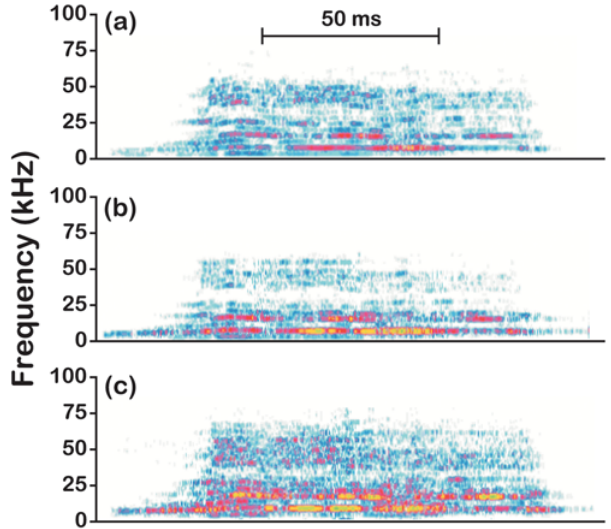
Figure 5. Distress vocalization of an object during UCS presentation. (a) Representative sonogram of an object distress vocalization recorded in real-time without the demonstration compart- ment enclosed by Plexiglas H . (b) Sonogram of the same vocalization played back through a speaker without the demonstration compart- ment enclosed. (c) Sonogram of the same vocalization played back through a speaker with the demonstration compartment enclosed. Color-coding indicates the relative decibel level for the call, with blues representing low-intensity energy and red/yellow representing high- intensity energy.